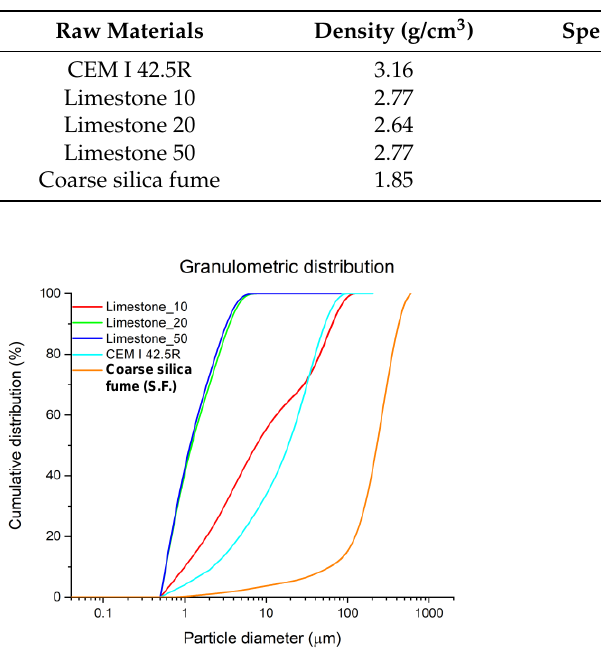
Table 3. Density and specific surface area (Blaine) of the raw materials used to manufacture ternary cements.